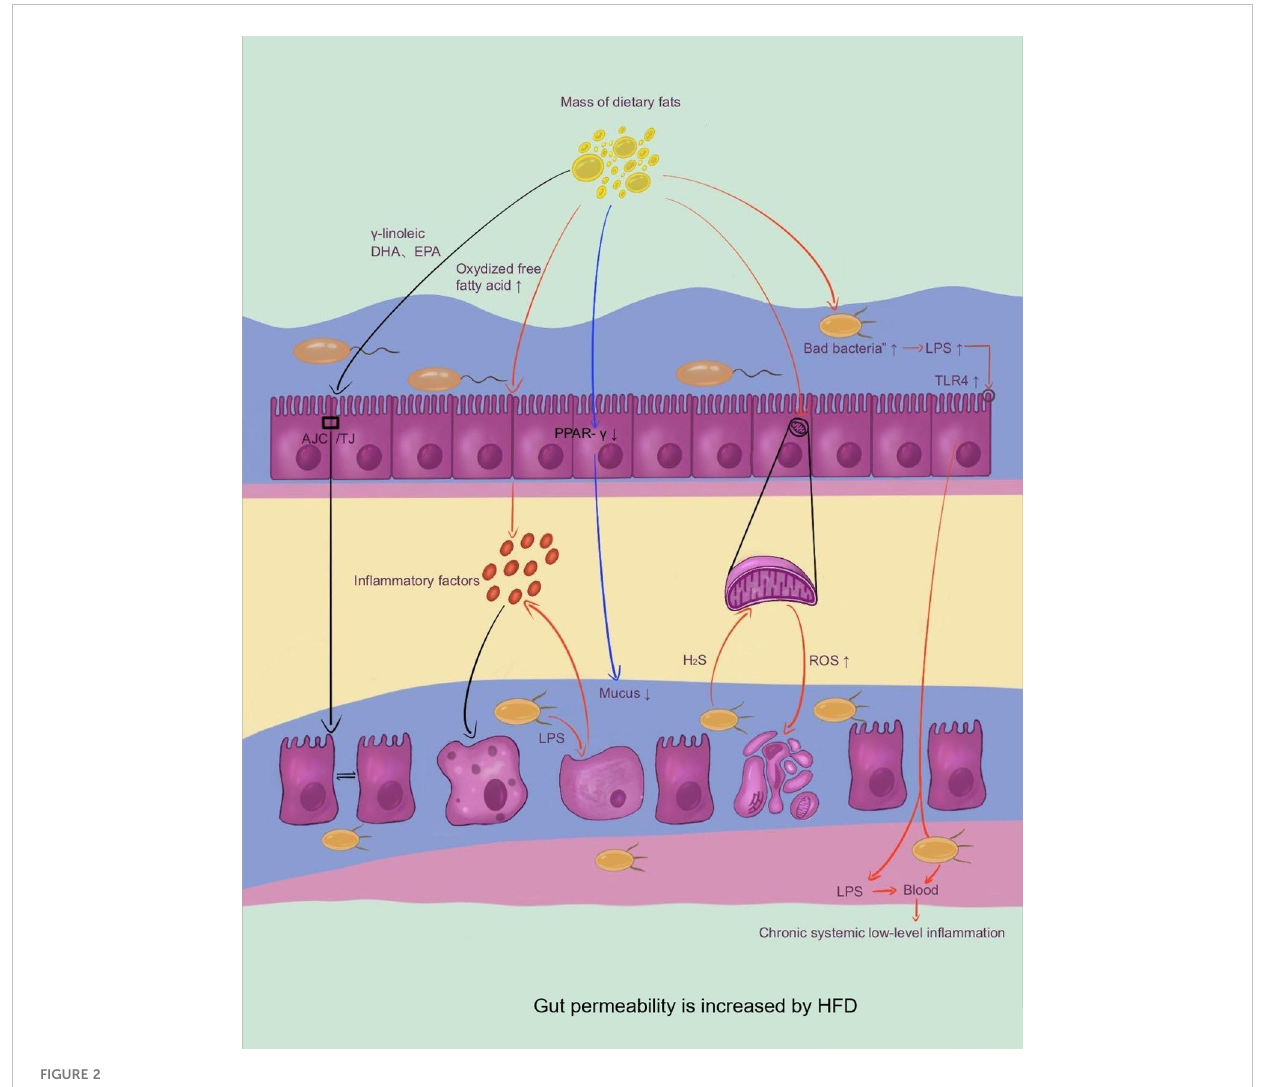
FIGURE 2 Gut permeability is increased by